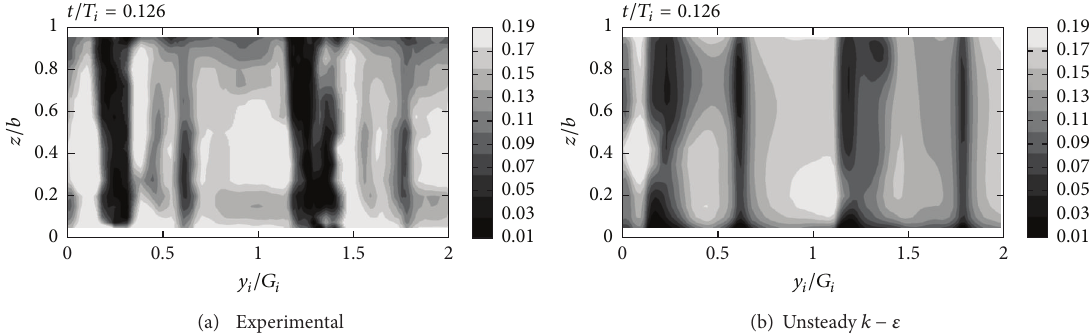
Figure 8: Experimental and calculated radial velocities in the radial gap for the unsteady simulation using the 𝑘 − 𝜀 turbulence model.